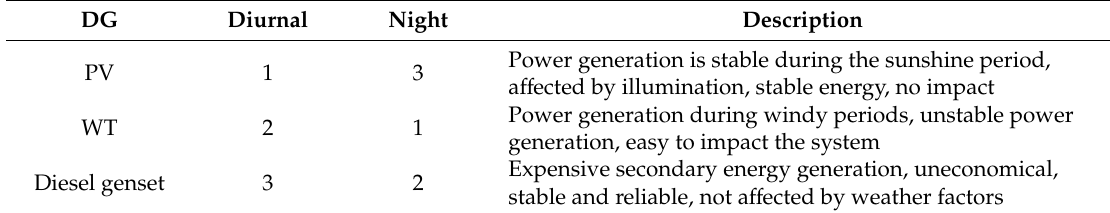
Table 2. Distributed power prioritization.